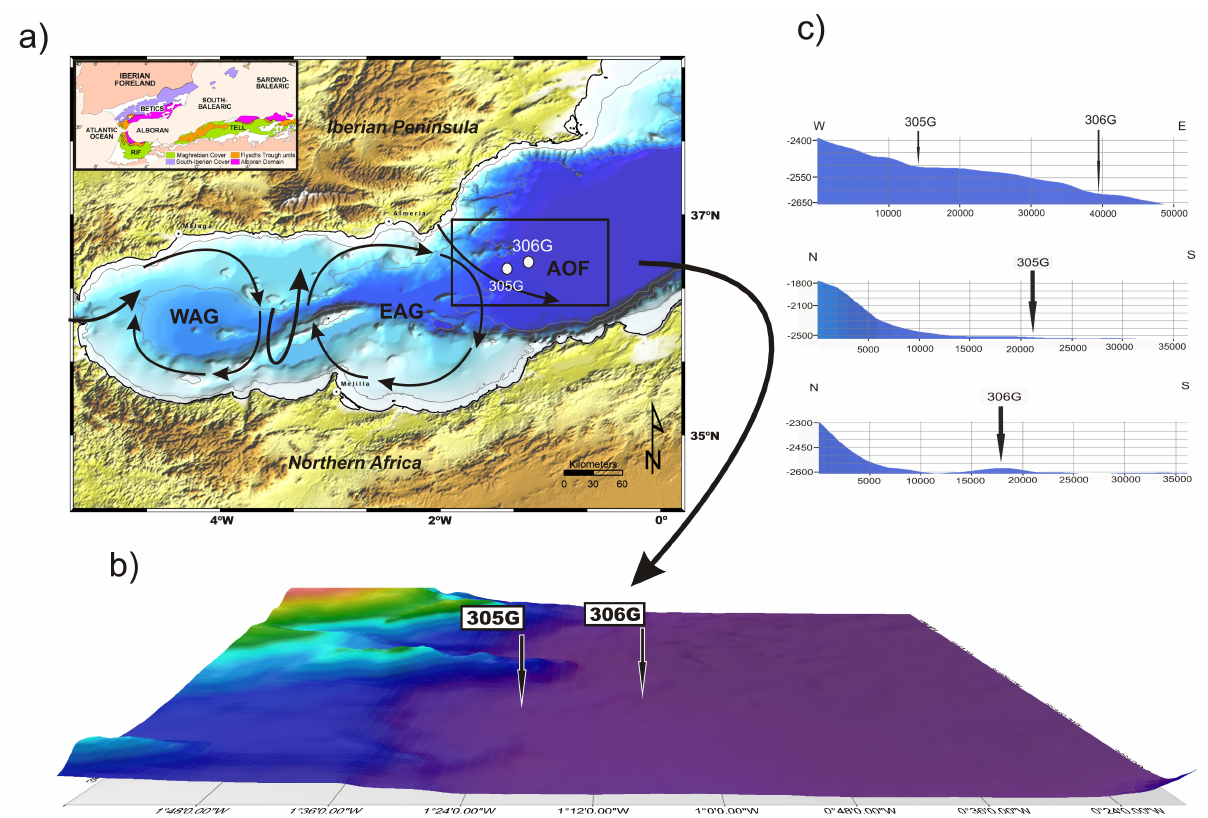
Fig. 1. (a) Site setting of the studied cores in the west Algerian-Balearic Basin (b) bathymetric map and (c) topographic profile showing the main physiographic features of the area under study. WAG: Western Alboran Gyre, EAG: Eastern Alboran Gyre, AOF: Almer´ıa-Or´an